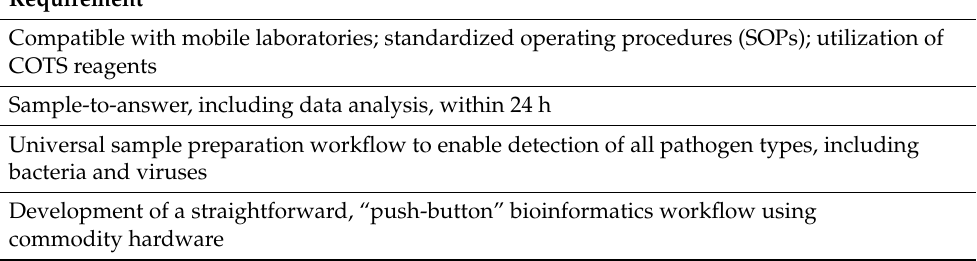
Table 1. Sample-to-Sequence Operational Requirements. This table summarizes the sponsor- specified operational requirements that were taken into consideration during the development of the PanGIA